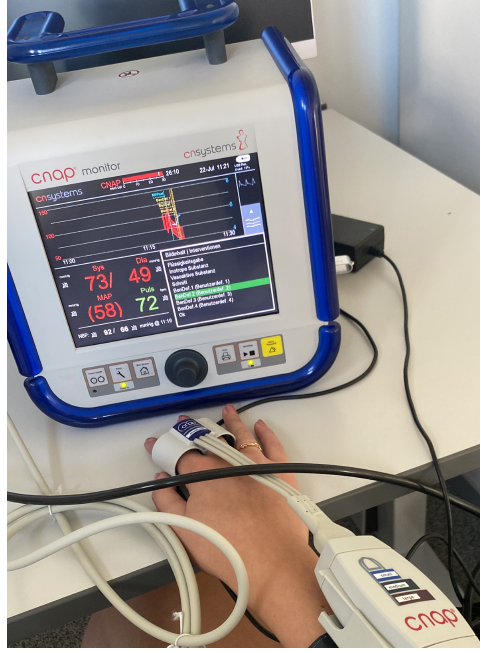
Figure 14. Close up of BP trend, estimated from CNAP ®